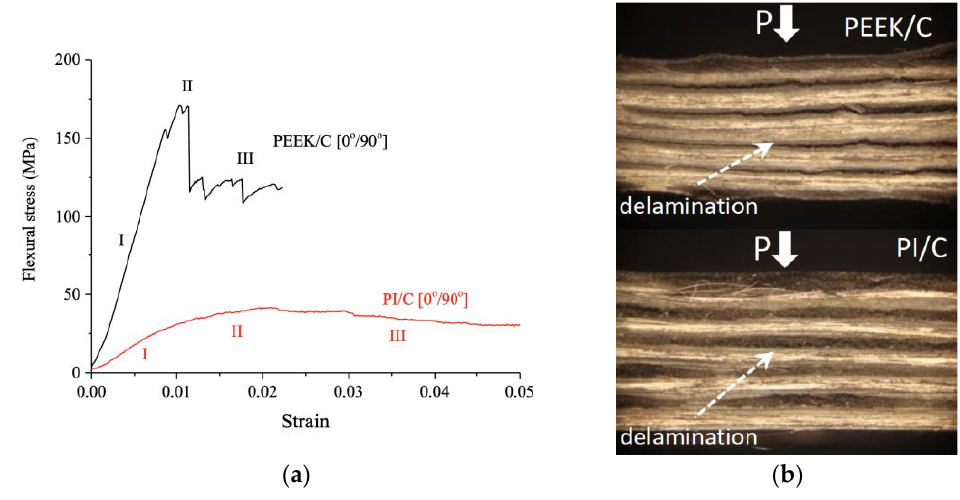
Figure 5. The flexural stress–strain curves ( a ) and optical images of the specimen cross-sections after the three-point flexural tests ( b ) for the PEEK/CF (0°/90°) and PI/CF (0°/90°) composites.